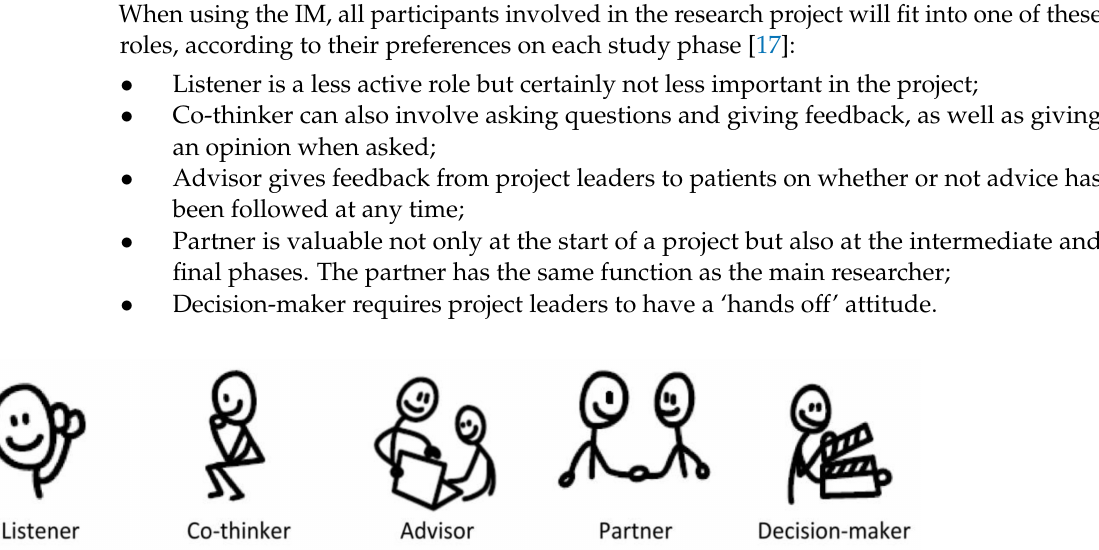
Figure 2. Illustration of the five roles for involvement in the Involvement Matrix. Accessed